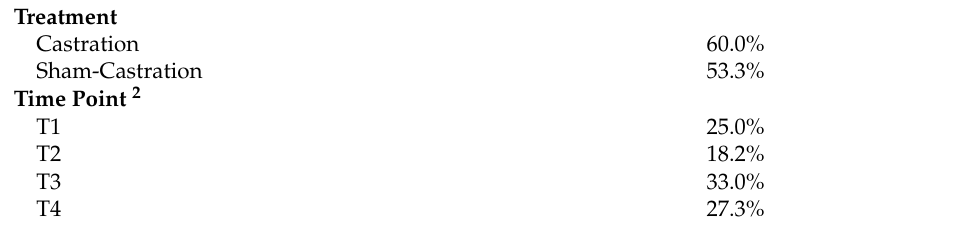
Table 2. Cross-validation discriminant analysis results utilizing all shape landmarks 1